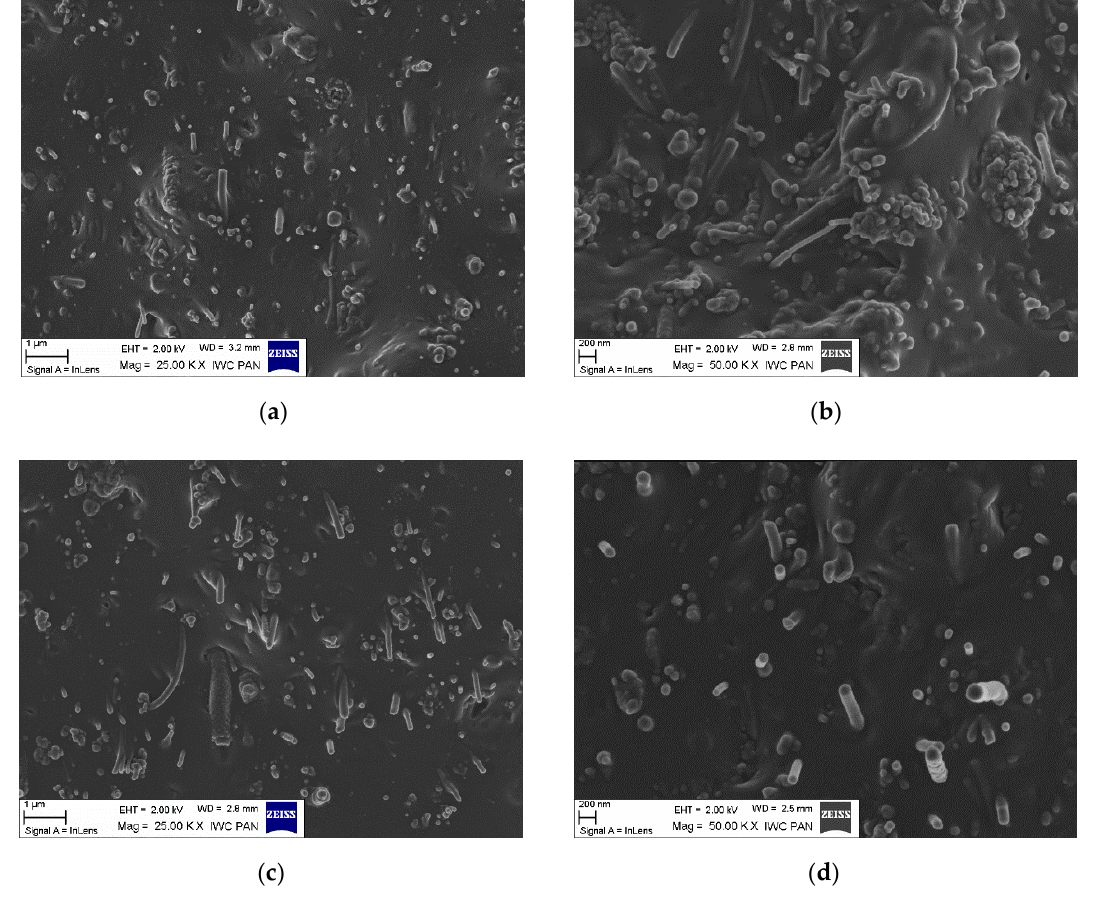
Figure 9. Scanning electron microscopy (SEM) images of NBR composites filled with ( a , b ) 10 phr of CNF, and ( c , d ) 10 phr of APTS-CNF.